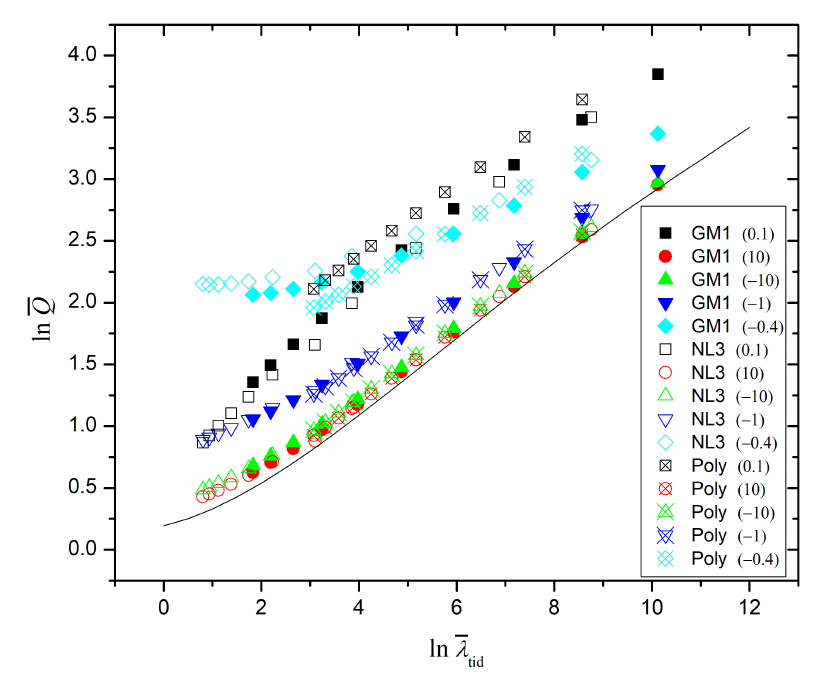
Figure 4. The breaking of the Q-Love relation for extreme spin ratios as illustrated by the polytropic (Poly), GM1, and NL3 EOS models. The numerical values inside the parentheses in the legend box denote the values of Ω n / Ω p . The solid line is the universal Q-Love relation for ordinary single-fluid neutron stars